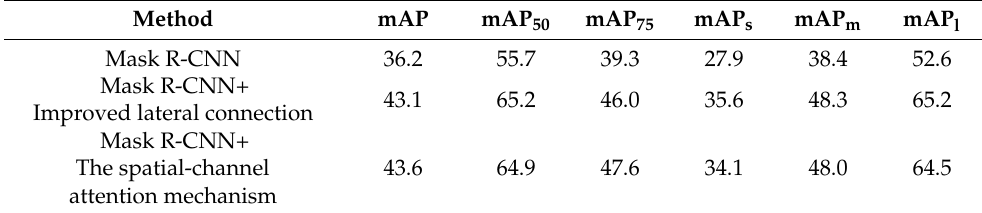
Table 4. Using different methods for object detection.